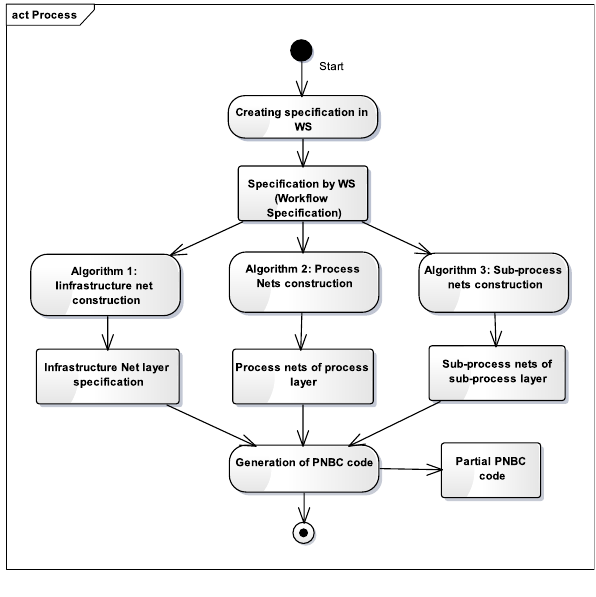
Fig. 4. The development process.